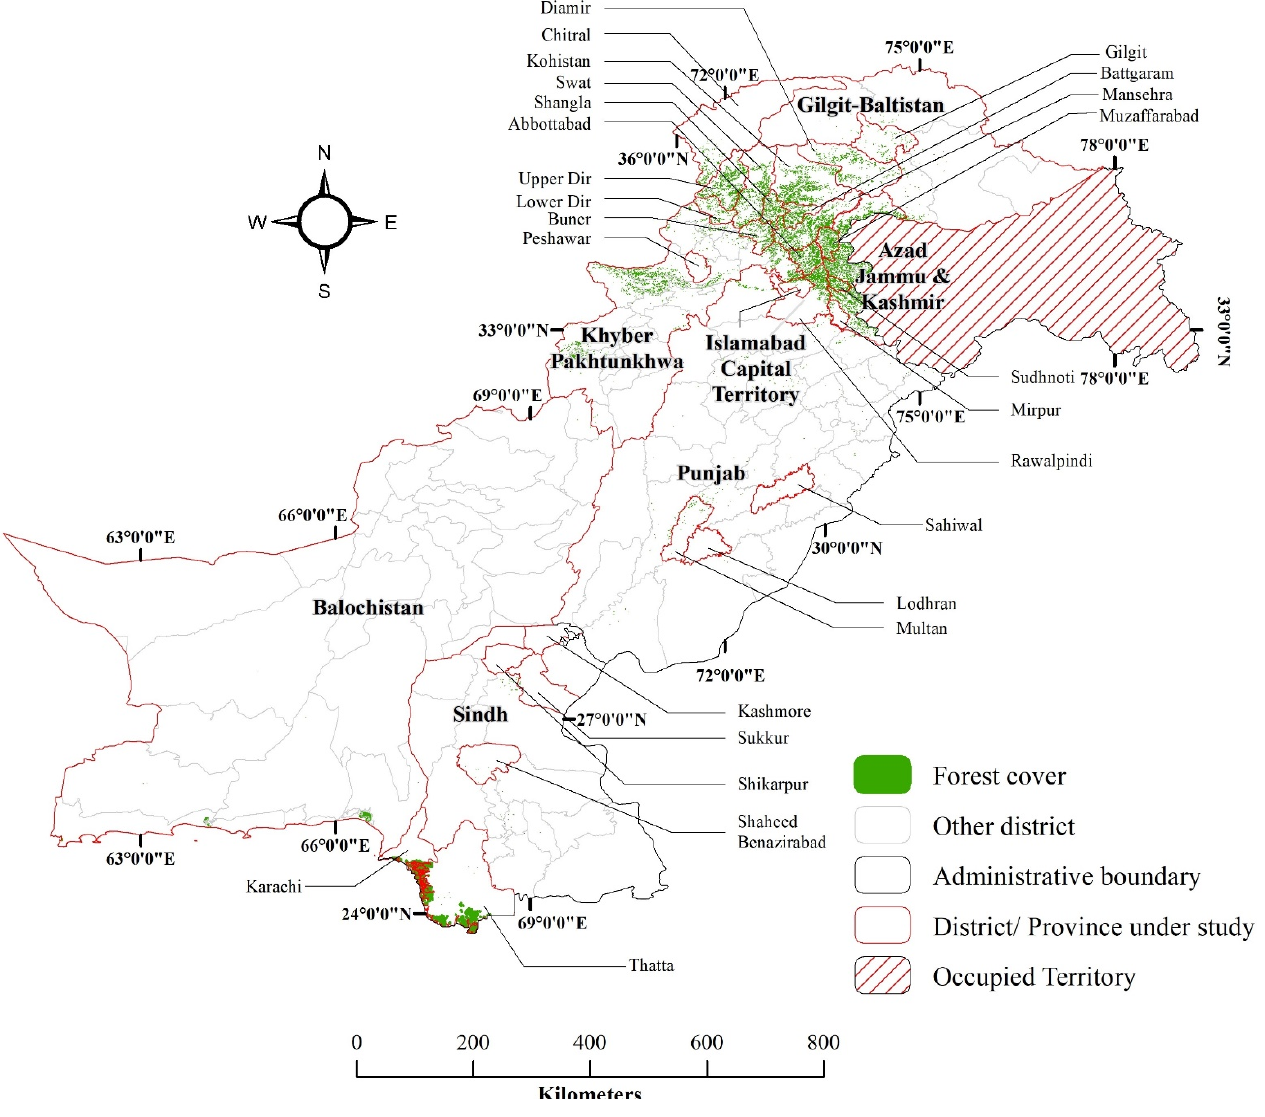
Figure 1. Geographical locations of 73 studies on forest mapping in Pakistan (1993–2021) laid over global forest/mangrove watch data set.